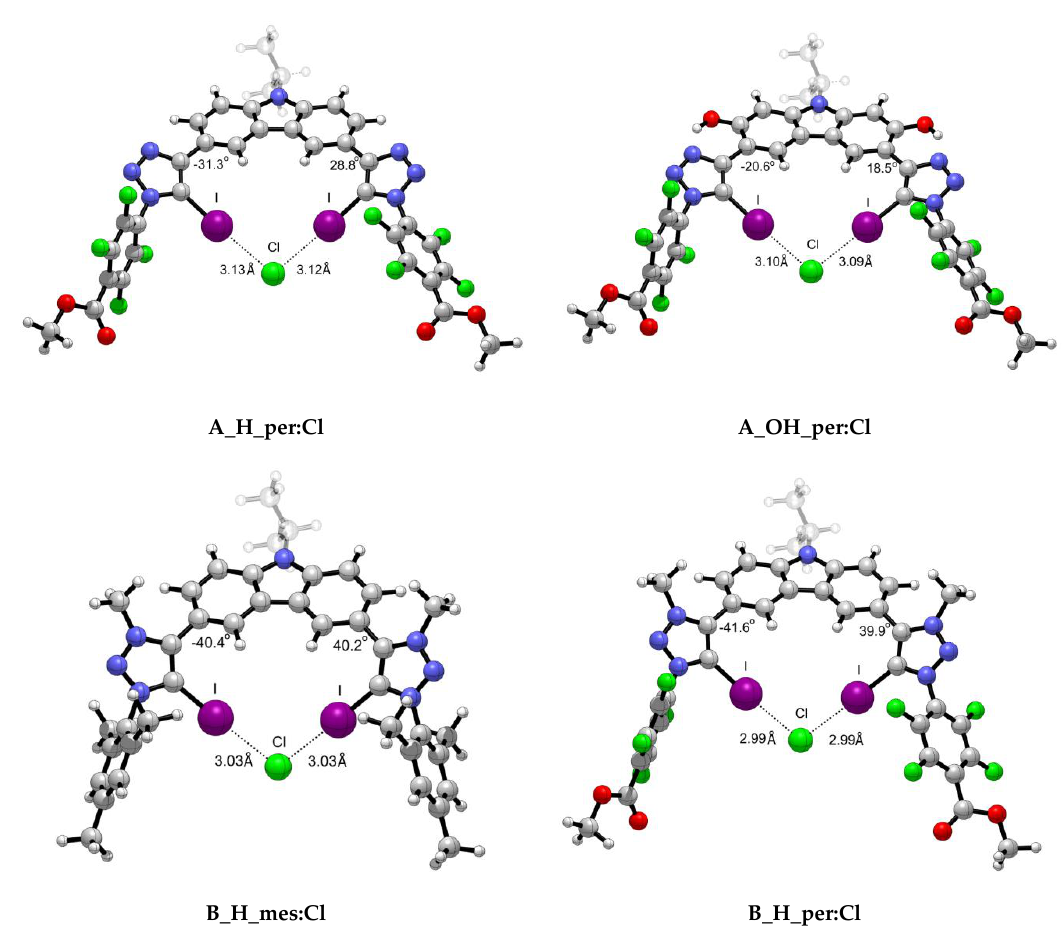
Figure 4. Representative optimised structures for the interaction between sca ff olds A and B with Cl −